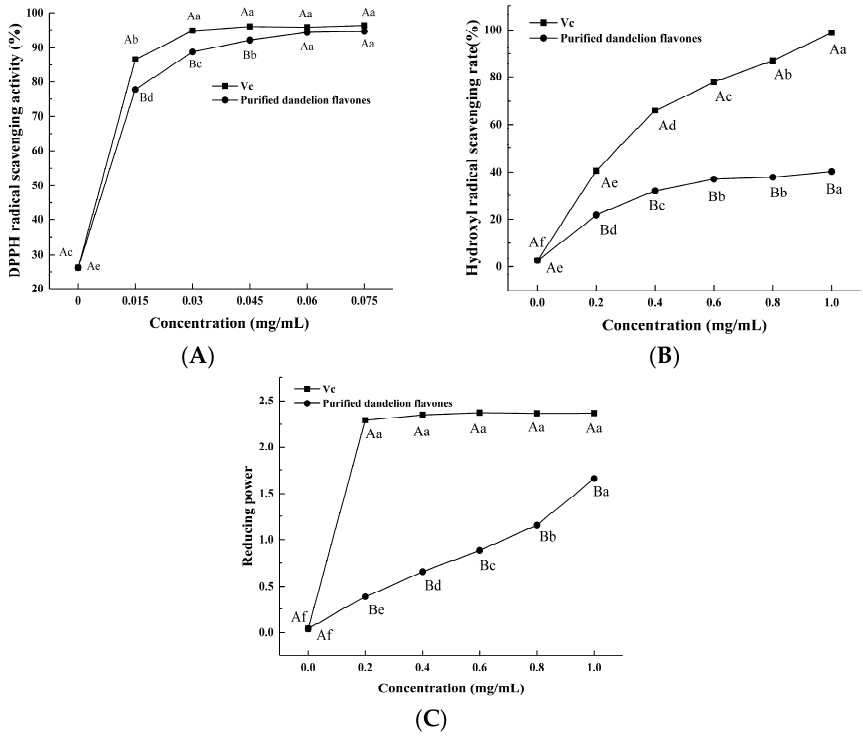
Figure 6. In vitro antioxidant activities of PFDF. ( A ) DPPH radical scavenging activity; ( B ) hydroxyl radical scavenging activity; ( C ) reducing power. Experiments were performed in triplicate, and data are expressed as the mean ± SE. Different uppercase superscript letters denote statistically significant differences between PFDF and VC ( p < 0.05). Different lowercase superscript letters denote statistically significant differences among different concentrations ( p < 0.05).